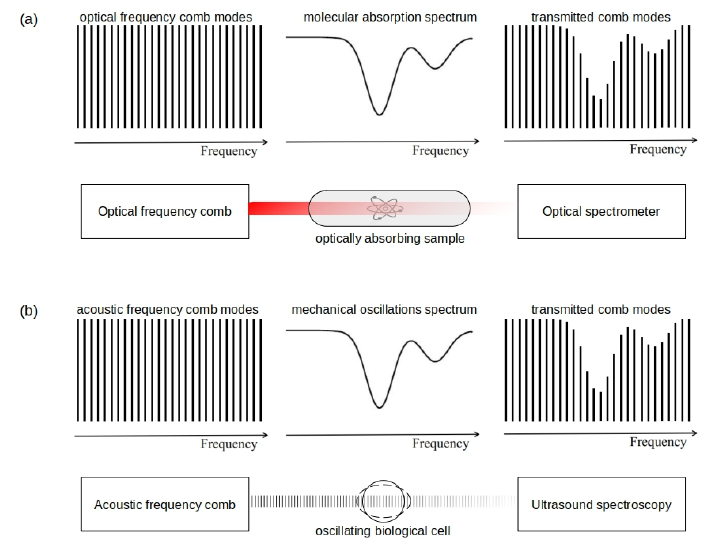
Figure 14. ( a ) Sketch of an OFC-based spectroscopy technique. The OFC as a broadband light source interrogates an absorbing sample and a spectrometer analyses the transmission spectrum revealing the sample’s molecular composition. ( b ) Sketch of a bubble-generated AFC-based spectroscopy technique implemented as an extension of mechanical property measurements of a biological cell illustrated in Figure 10b. AFC as a broadband acoustic pressure wave source interrogates a mechanically oscillating cell and an ultrasound spectrometer analyses the transmission spectrum that provides information about mechanical properties of the cell and its individual